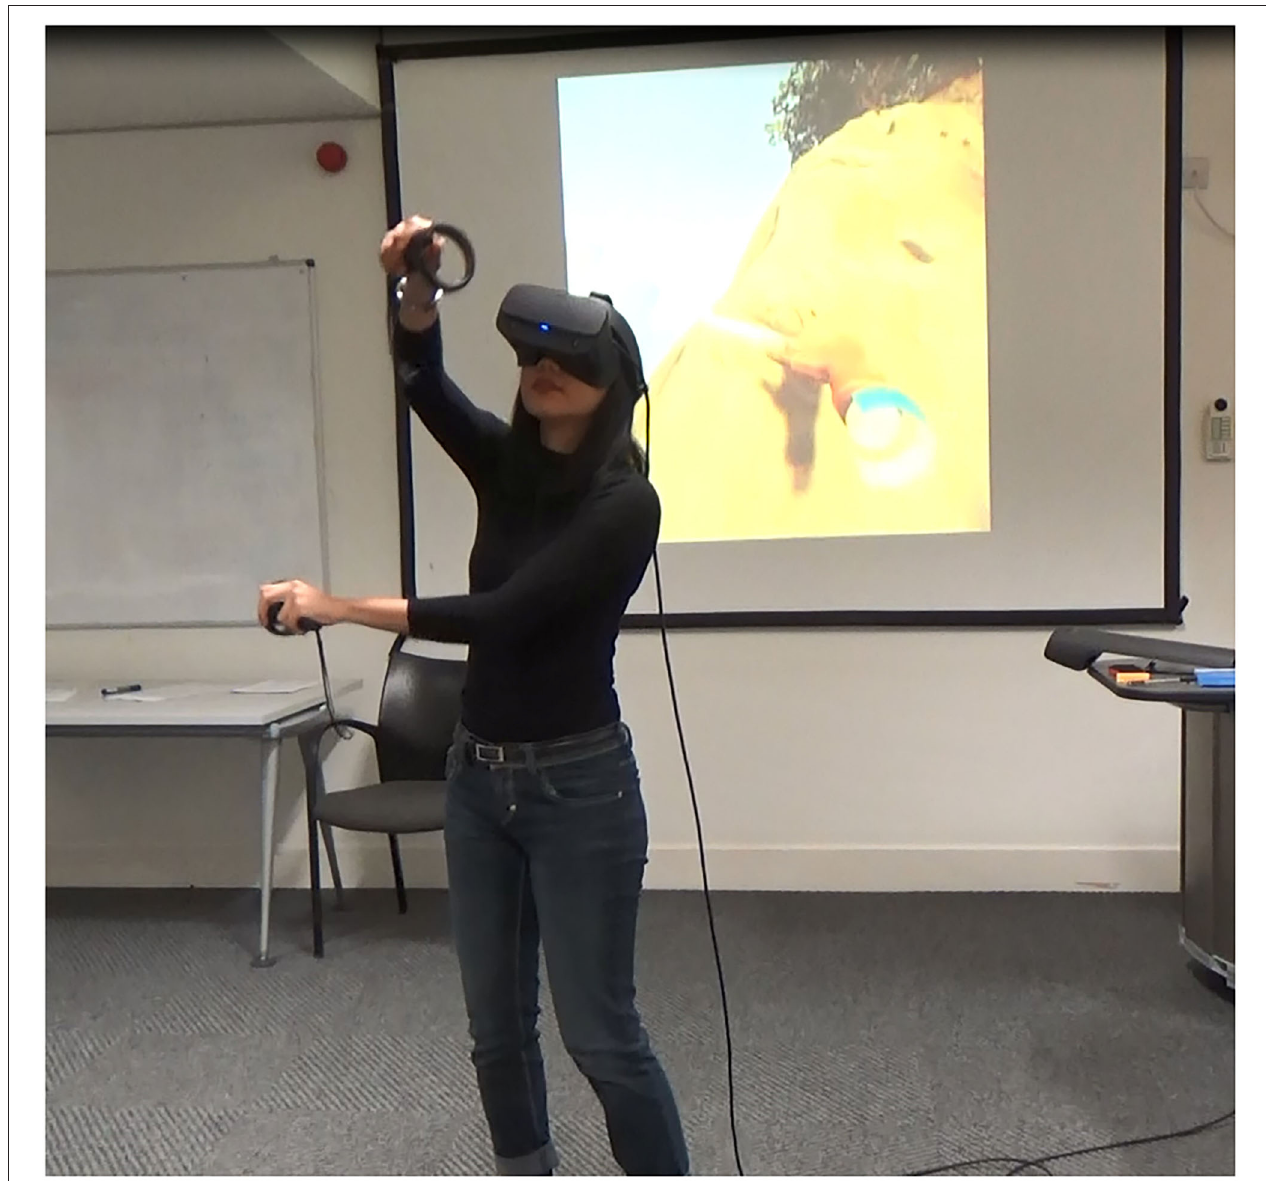
FIGURE 7 | Gripping controller, while virtual hand is reaching with palm open prior to grasping the